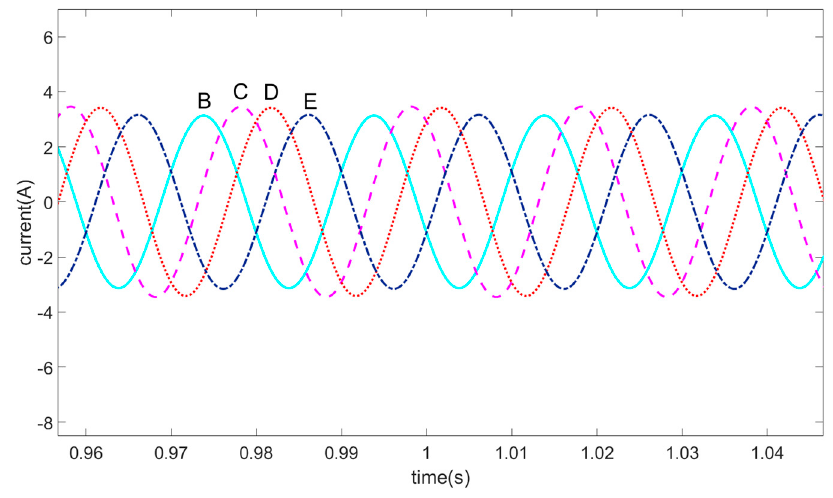
Figure 4. Schematic diagram of remaining four-phase currents when phase A is an open-circuit fault.